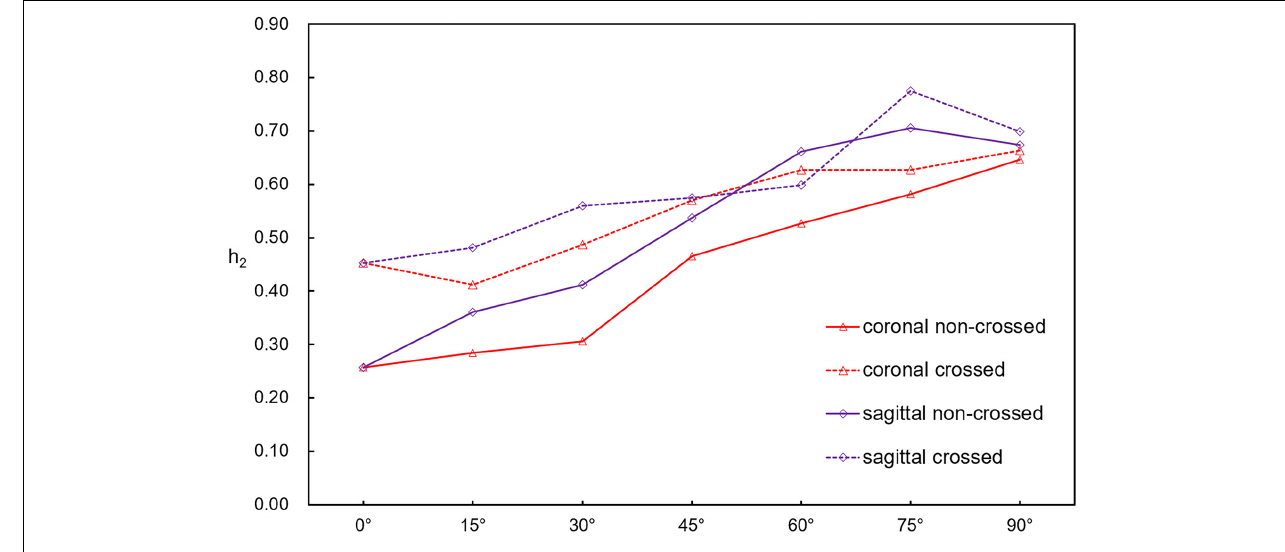
FIGURE 11 | Line plot of helicity h2 with aneurysm neck